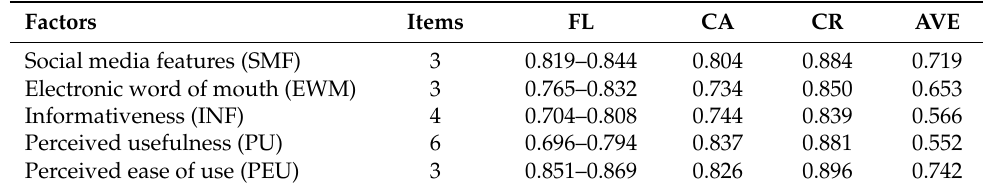
Table 2. Factor-loading